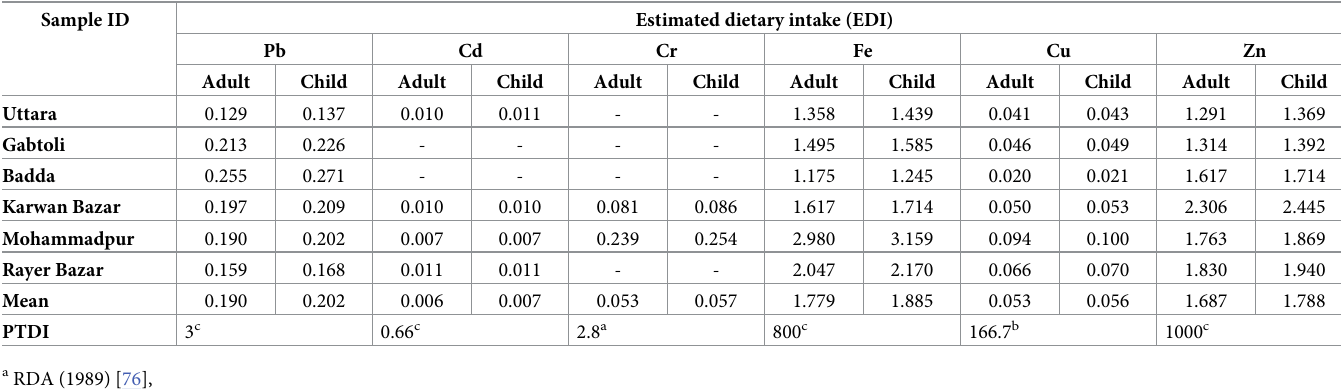
Table 5. Estimated dietary intakes (EDI) ( μ g kg − 1 BW − 1 day − 1 ) of heavy metals from the consumption of chicken meats by the people of Bangladesh. Sample ID Estimated dietary intake (EDI)